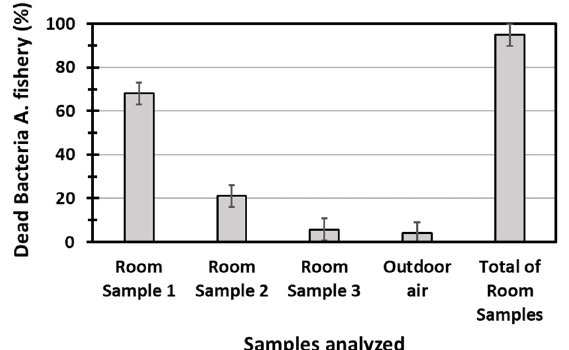
Figure 6. Toxicity levels measured with the Microtox ® test, performed on the water samples collected in the testing room during a pulsed experiment performed with diesel exhaust emission. Sampling was performed by passing the air through the GIOEL cleaner operated at the maximum suction rate for 40 min. Room samples, numbered from 1 to 3, were collected at a 10 min interval one from the other. The outdoor sample was collected after the room was maintained for more than 1 h, in communication with the outdoor atmosphere.